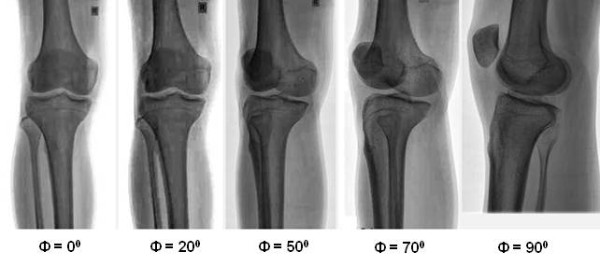
Benchmark X-rays taken atpredetermined rotation angles.